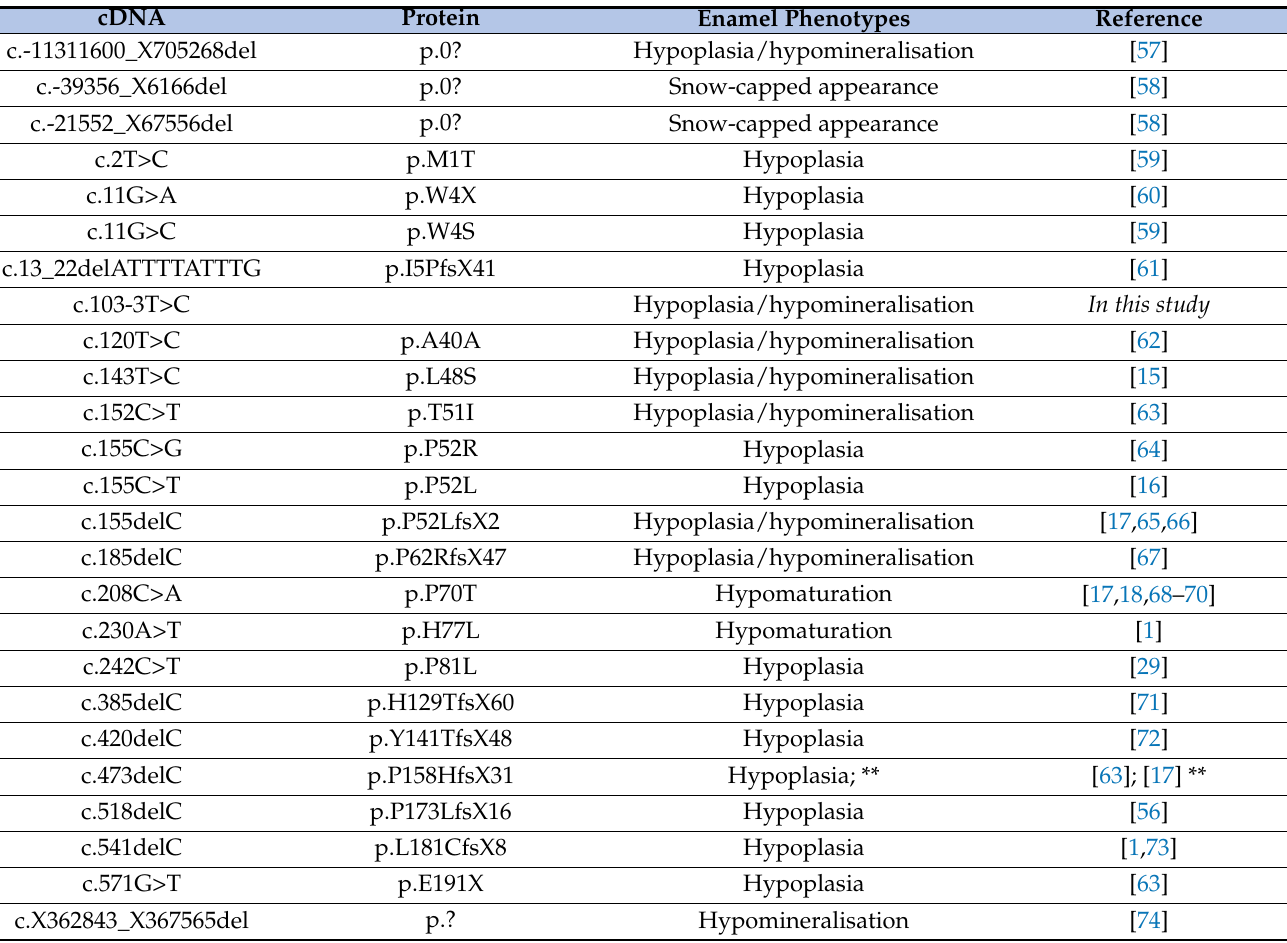
Figure 4. Diagram showing disease-causing variants, named according to the reference sequence NM_198488.5, identified in reported families with hypocalcified AI. The FAM83H domains are shown in coloured boxes. The bottom line shows the range of amino acids in particular domains (blue: highly conserved N-terminus domain encompassing amino acids 17–281; yellow: intermediate region encompassing amino acids 282–675; green: highly conserved C-terminus domain encompassing amino acids 676–1179). The disease-causing variants shown in black are associated with the gener- alised phenotype, those in green with the localised phenotype, and those in blue with the attenuated phenotype. The variant identified in this study is shown in red. Table 3. Review of the disease-causing variants described in the AMELX gene (NM_182680.1) and related clinical